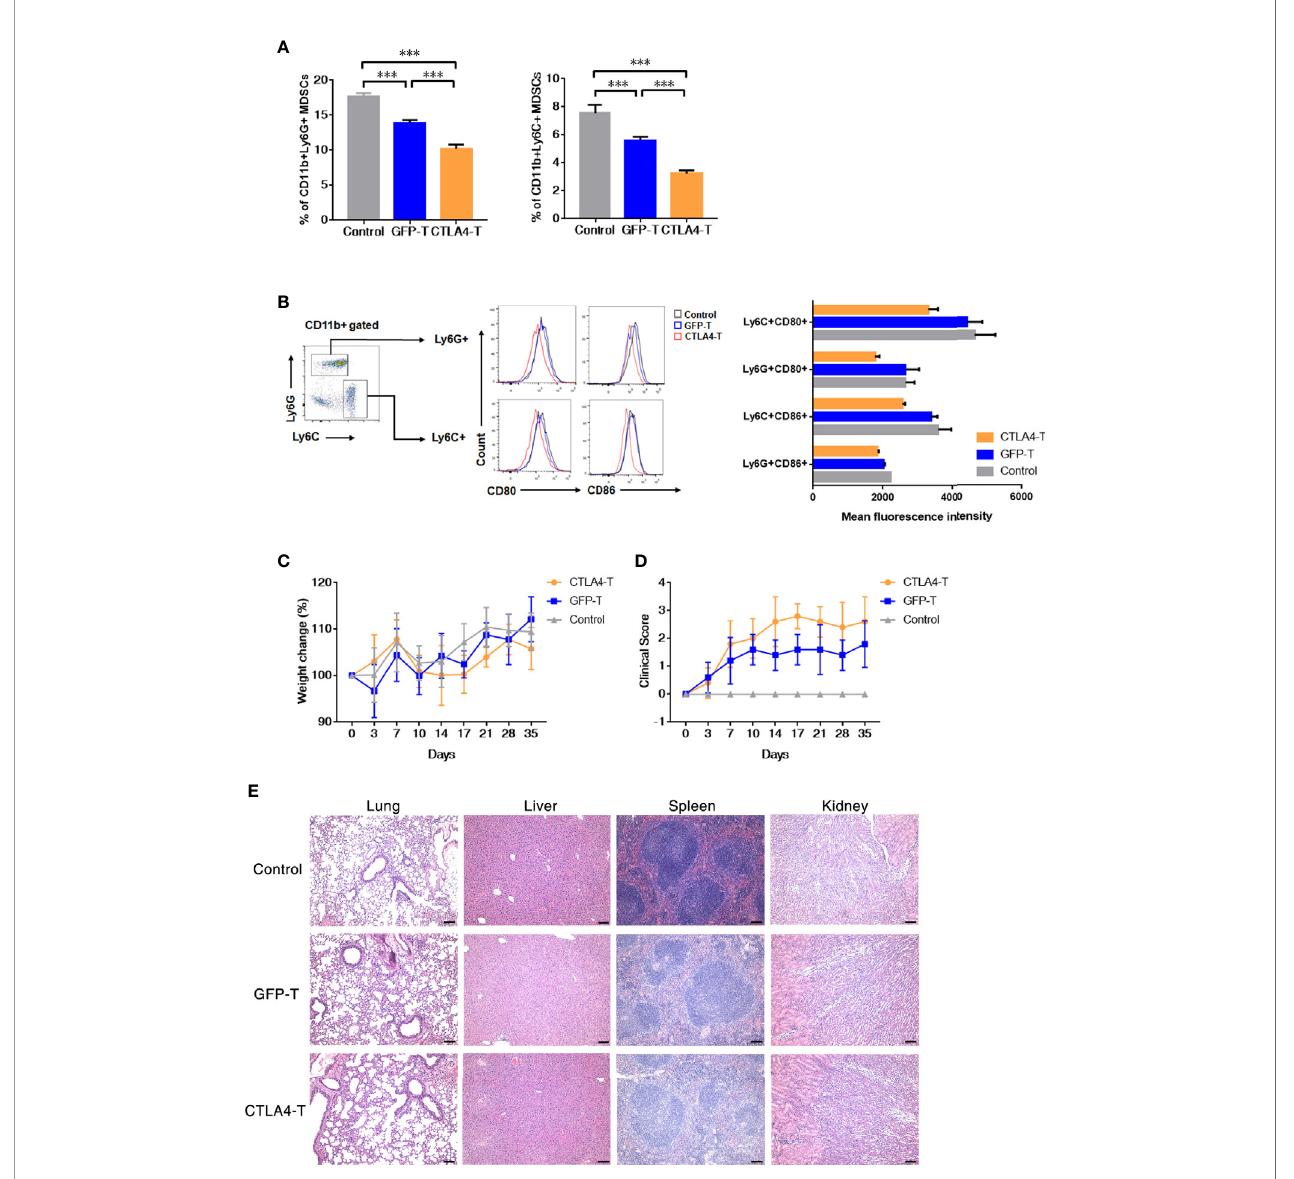
FIGURE 4 | Murine CTLA4-chimeric T cells show toxicity against MDSCs. (A) Statistical analysis of MDSCs percentage with tumors by fl ow cytometry, mean ± SD, one-way ANOVA. (B) Representative fl ow cytometric analysis of the expression of CD80 and CD86 on MDSCs after CTLA4-CAR T cell therapy. (C) Weight change of autologous mice (n = 5) after T cell transfer. (D) Mice were monitored for GVHD pathology score twice a week. (E) H&E staining of organs, scale bar, 100 m m. Signi fi cance values: *** P <